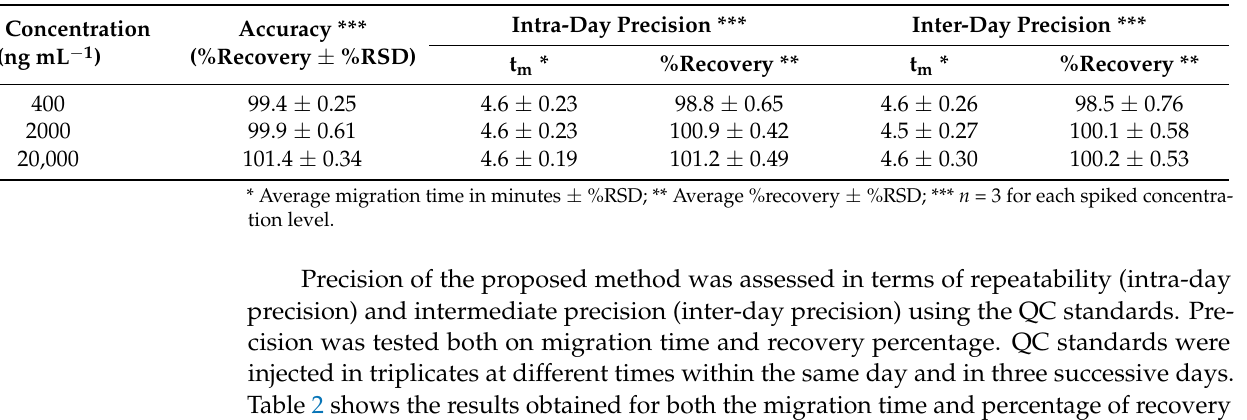
Table 2. Accuracy and precision results of Ni II (3-OMe-salophene) determination under the proposed CZE